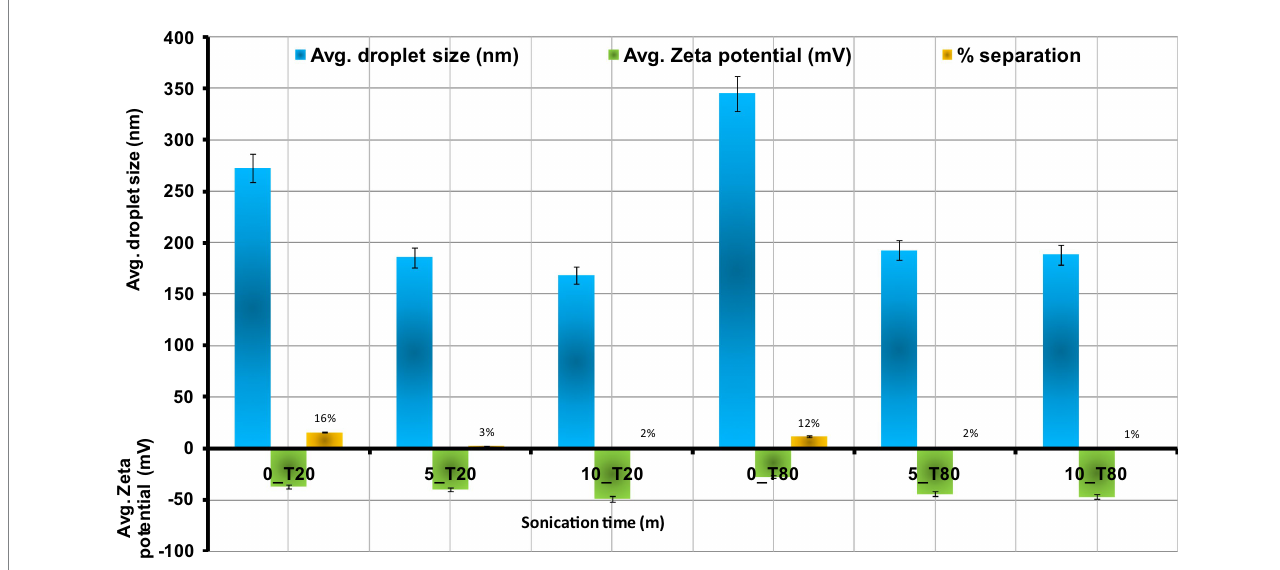
FIGURE 4 Effect of sonication time on the droplets size, zeta potential, and separation % of Nigella sativa oil nanoemulsions using ultra-sonication method means ± SD ( n =